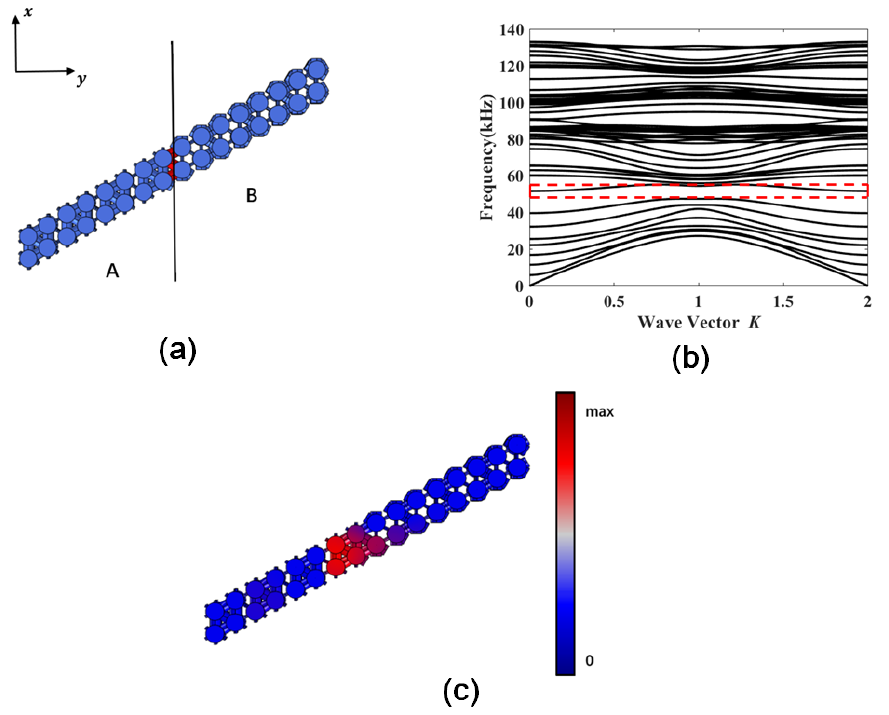
Figure 5. ( a ) Diagram of the supercell structure. ( b ) Dispersion curve of the supercell. ( c ) Displace- ment fields of the supercell.